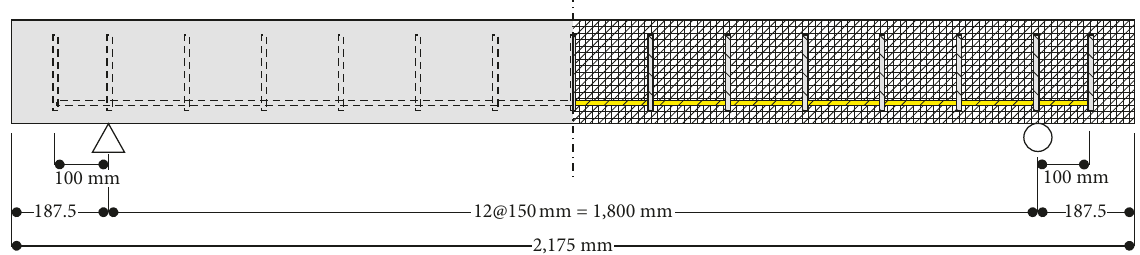
Figure 4: Arrangement of longitudinal reinforcement and stirrups in RC beams used in this study [25].